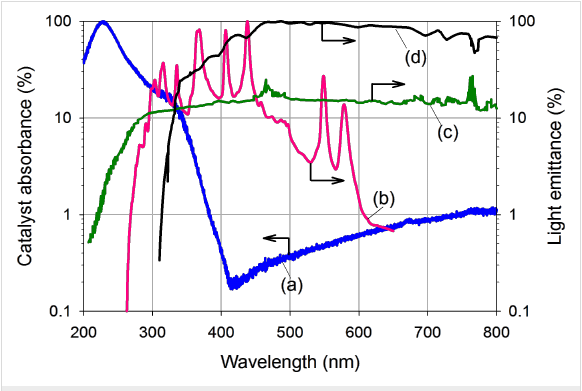
Figure 1: The spectrum of: (a) UV–vis absorption of V-Ti/MCM-41, and emission of (b) 200 W mercury arc lamp, (c) 300 W Xe lamp (extracted from [22]) and (d) AM1.5G filter